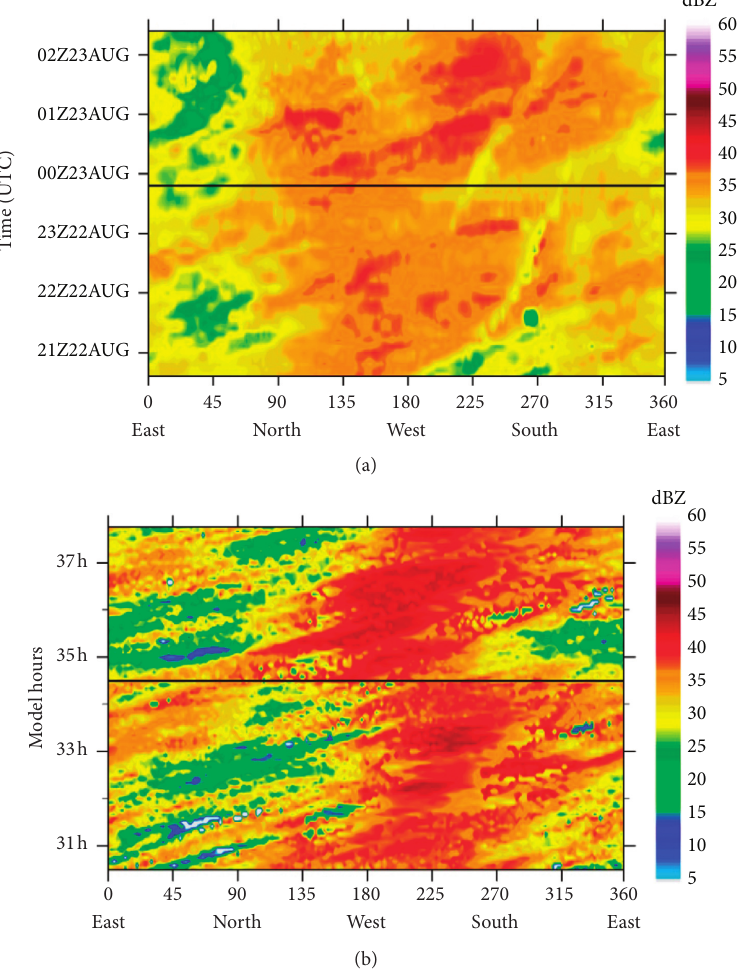
Figure 7: Variation of the average radar reflectivity in the eyewall (radius of 20–80km) at 3km altitude with time and azimuth in (a) radar observations and (b) WRF simulation. In (a) and (b), the horizontal black line marks the division between two (Figure 9(c)): rapid intensification (with a mean IR of